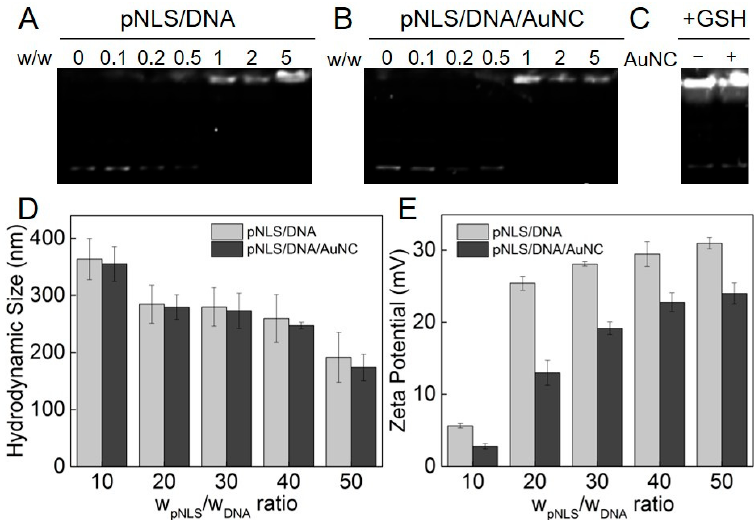
Figure 1. DNA compaction capability. Agarose gel electrophoresis retardation assay of ( A ) pNLS/DNA complexes and ( B ) pNLS/DNA/AuNC complexes in 10 mM phosphate buffered saline (PBS); and ( C ) complexes without or with AuNC at pNLS/DNA weight ratio of 10 in 10 mM GSH. Hydrodynamic size ( D ) and zeta potential ( E ) of pNLS/DNA complexes and pNLS/DNA/AuNC complexes at different weight ratios.